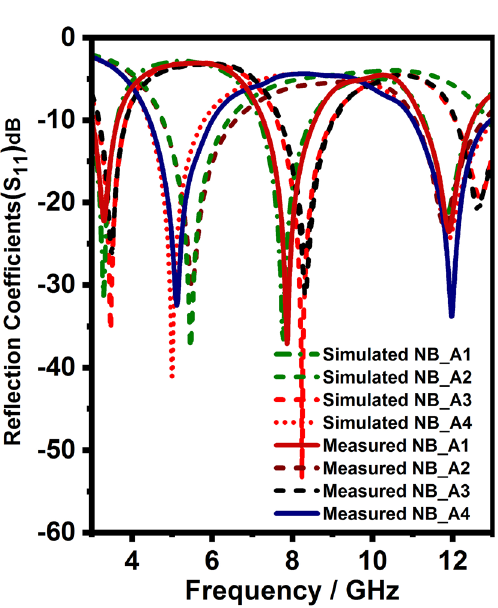
2 element UWB MIMO antenna. ×